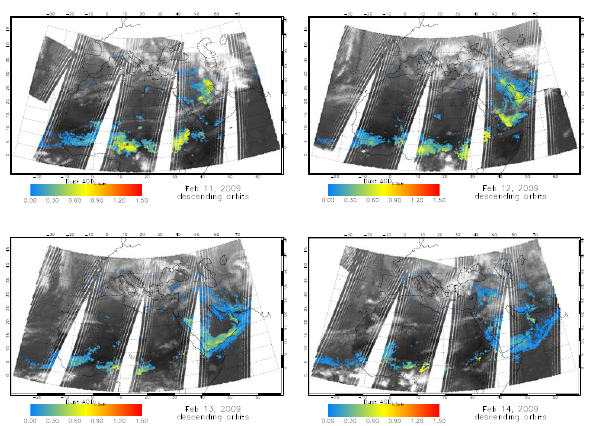
Fig. 5. AVHRR RGB composites (left) and IASI dust effective radius (right) for 12 (top) and 13 February (bottom).